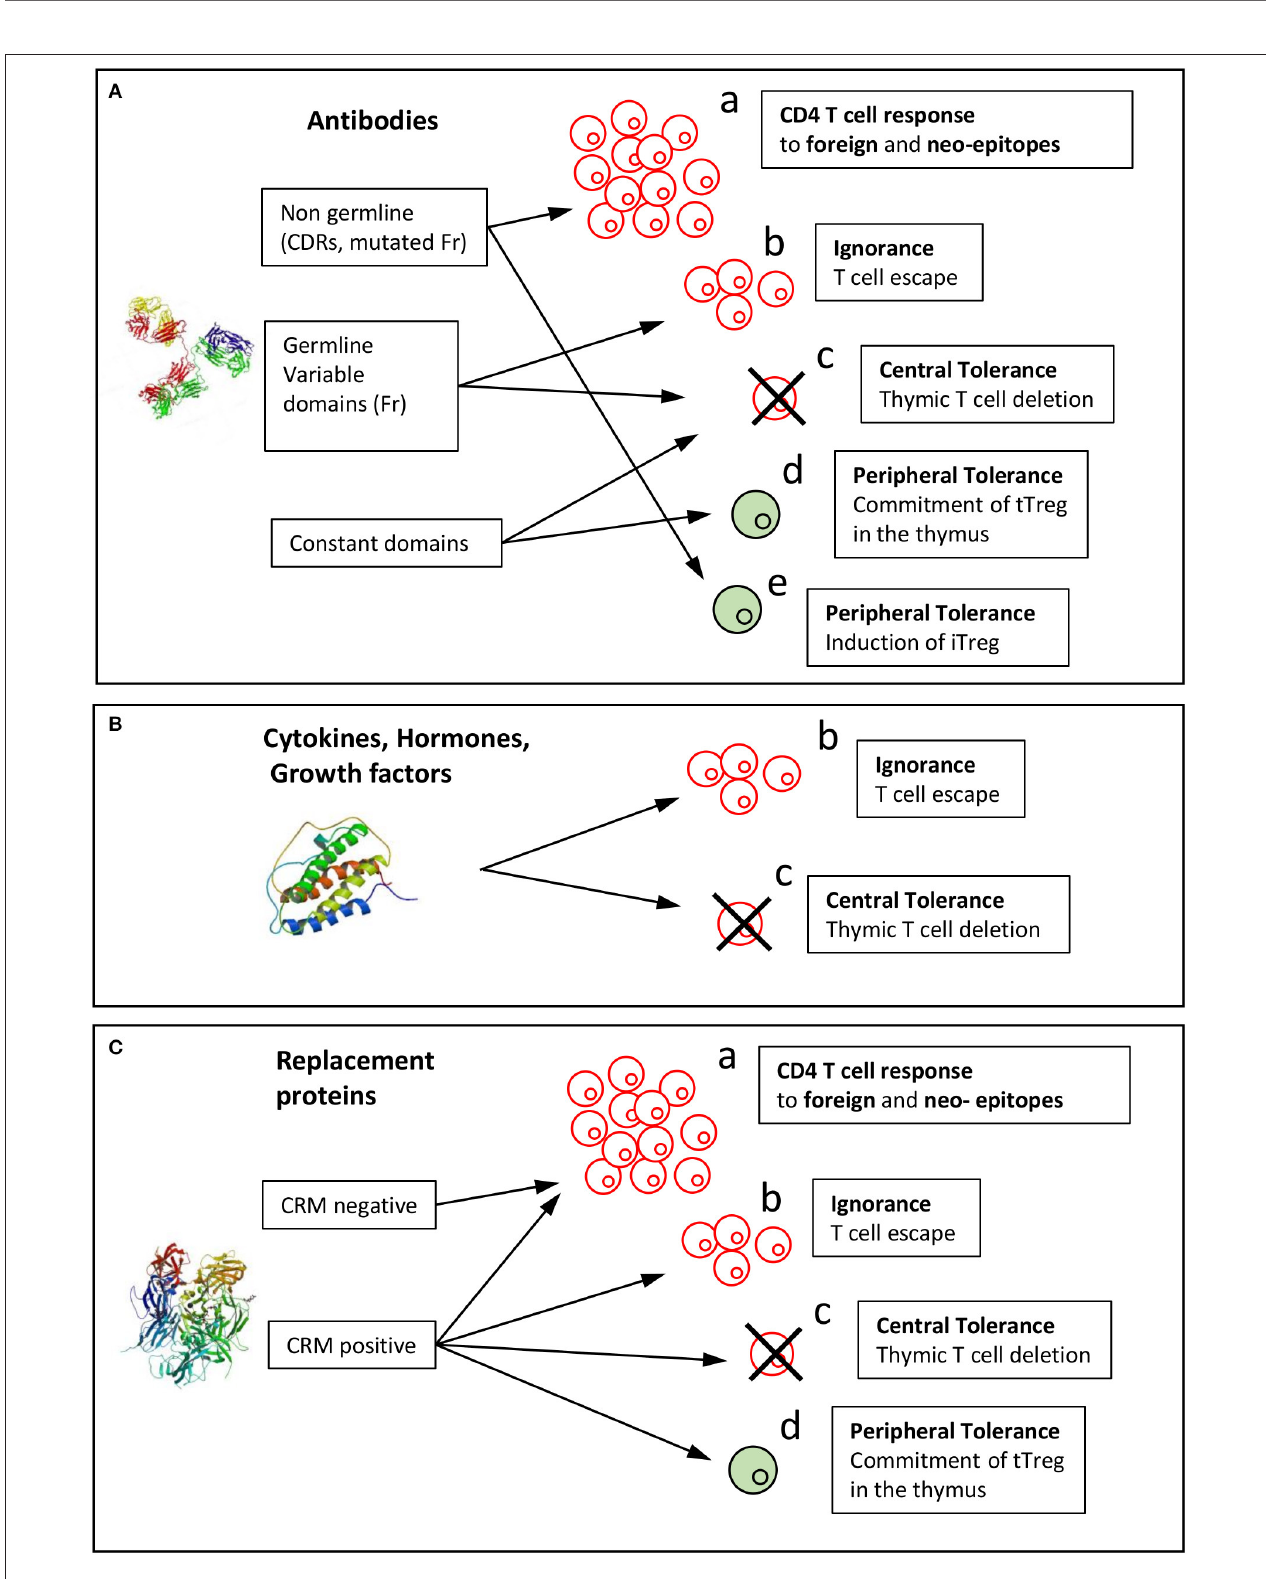
FIGURE 3 | Mechanisms of induction of the T cell response or tolerance to biopharmaceuticals. Immunological mechanisms involved in the immunogenicity of BPs are reported for the three categories of BPs: (A) antibody, (B) cytokines, hormones, growth factors, (C) replacement proteins. Biopharmaceuticals might be